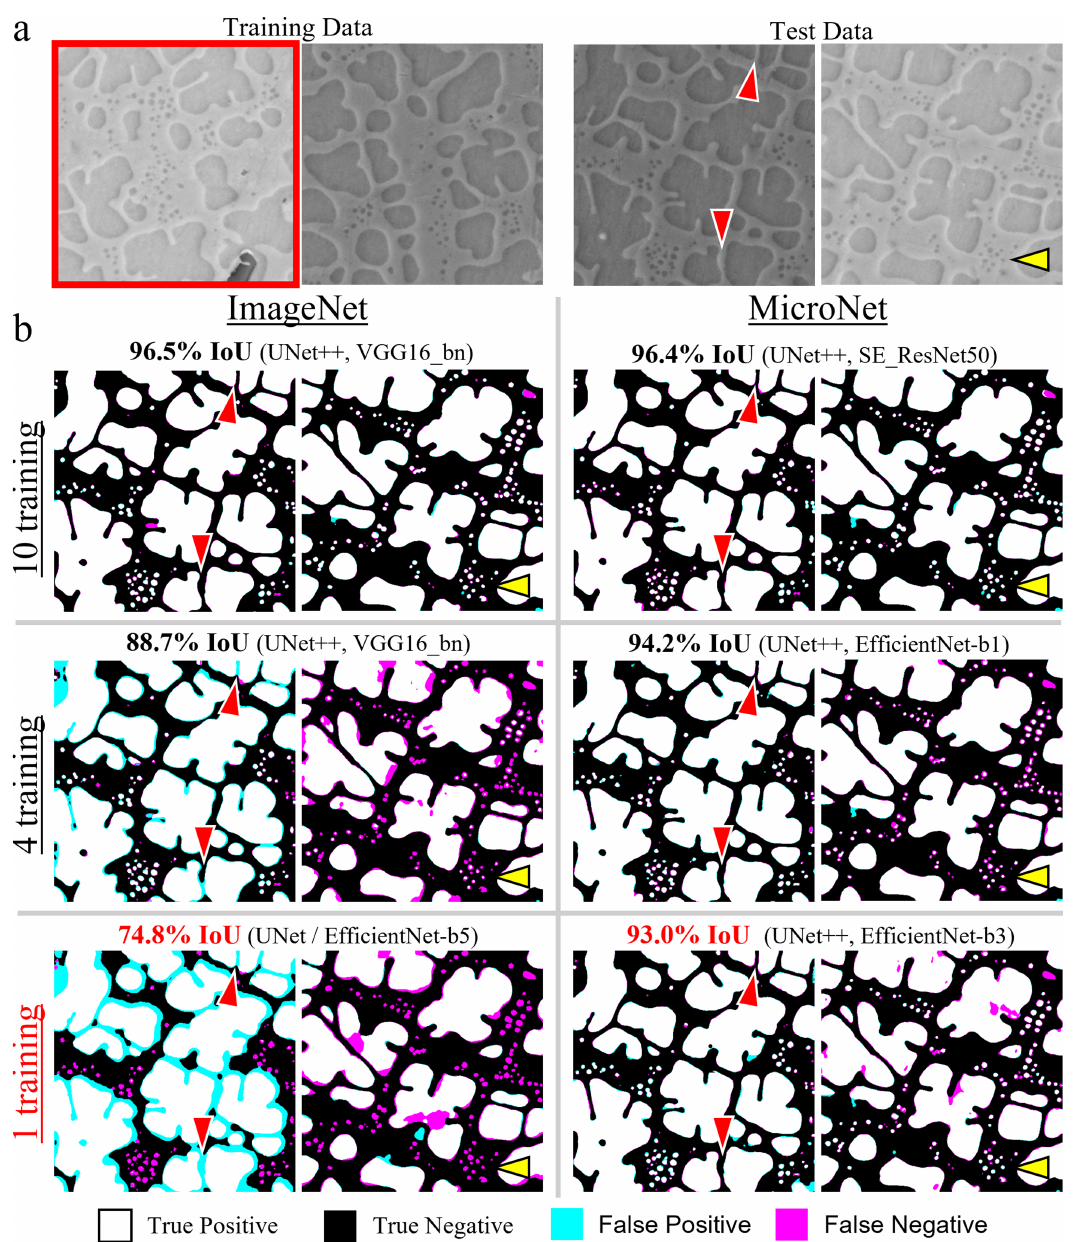
Fig. 3 Segmentation results on Ni-superalloys. a shows images from the training and test data splits. Super-1 had ten training images. Super-2 had four images. Super-3 had only one training image which is outlined in red. b show the segmentation accuracy masks for the highest accuracy ImageNet and MicroNet models for the fi rst three Super datasets. White pixels indicate true positive predictions, black is true negative, cyan is false positive, and magenta is false negative. The left column shows the models pre-trained on ImageNet. As the number of training images reduce, there is a dramatic reduction in segmentation IoU accuracy. The right column shows the models pre-trained on MicroNet. Even with only 1 training image, the model accuracy is only slightly reduced when pre-training on MicroNet. Red and yellow triangles are placed at the same location in each ground truth and segmentation accuracy mask for the left and right test image respectively. The red triangles indicate an example where ImageNet models over-segment and combine secondary precipitates where the MicroNet models accurately segment the precipitate edges and maintain precipitate separation. The yellow triangles indicate an example where MicroNet models accurately identify tertiary precipitates that were not identi fi ed by ImageNet models in the few-shot and one-shot